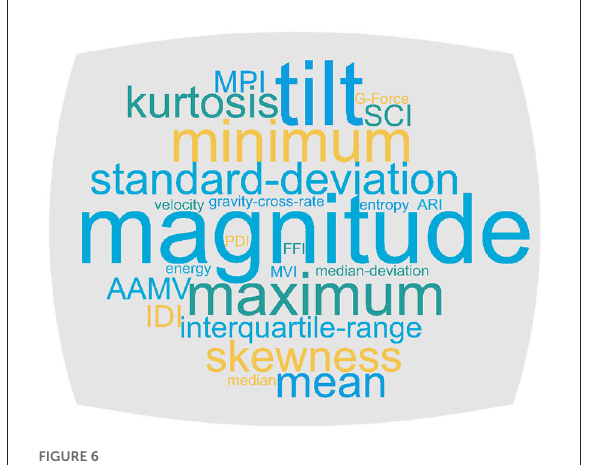
FIGURE6 Wordcloud of features engineered in the selected papers. Larger fonts represent higher frequencies, with magnitude and tilt the most